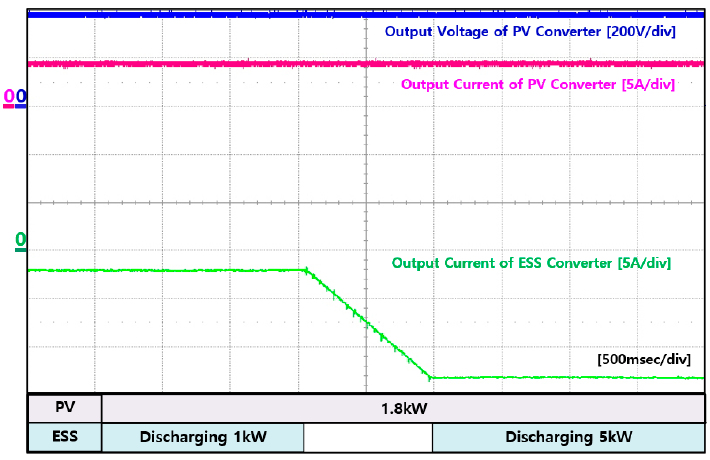
Figure 28. Experiment waveforms of DC load and multi-level inverter in mode 5.